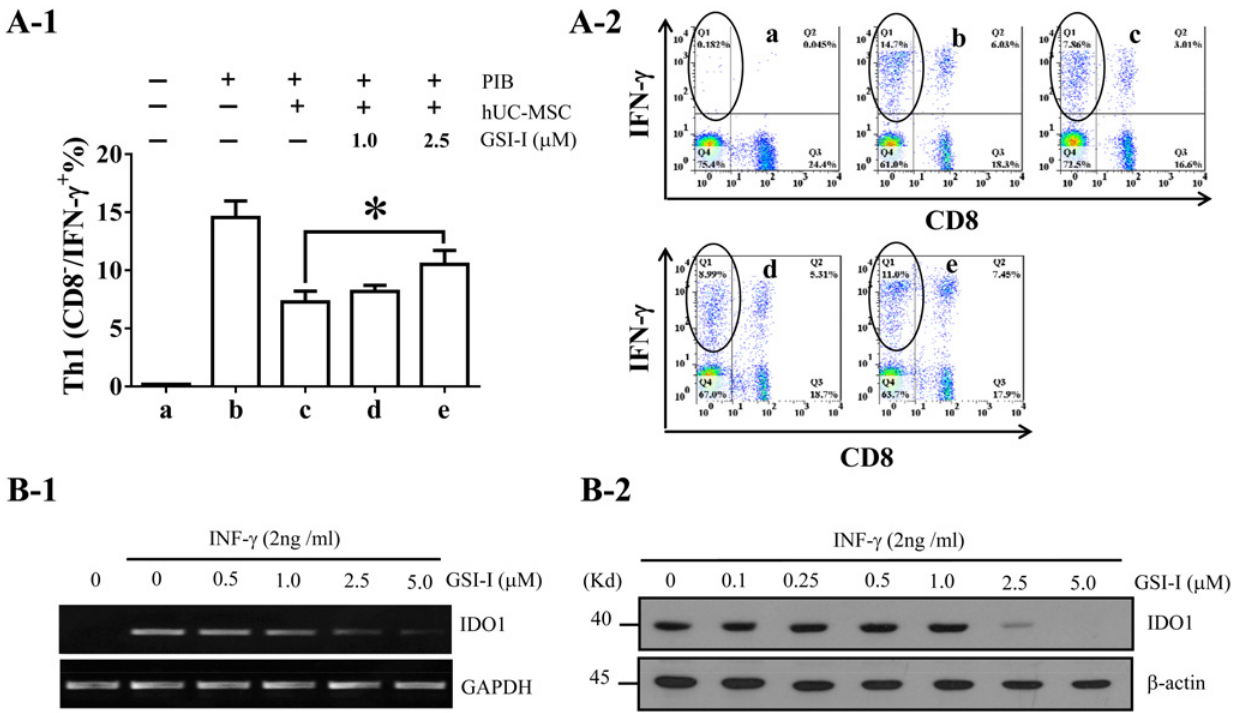
Fig 4. The GSI-I treatment inhibits hUC-MSC activities in suppressing Th1 lymphocyte proliferation and IDO1 expression. A. Flow cytometry assay shows that co-culturing of hUC-MSC with PBMC in 1:5 ratio significantly inhibits Th1 lymphocyte proliferation. However, the treatment with 2.5 μ M GSI-I significantly inhibits the effect of hUC-MSCs on Th1 proliferation. A-1: bar figure; A-2: original spectrogram of a representative Th1 lymphocyte analysis. Th1 lymphocytes are CD8-/IFN-g+ cells as circled in the spectrogram. B. The GSI-I treatment reduces the IFN- γ -induced IDO1 expression. Both semi- quantitative RT-PCR (B-1) and Western blotting (B-2) show that, while 2ng/mL IFN- γ induces IDO1 expression in hUC-MSCs, greater than 2.5 M GSI-I dramatically reduces the IDO1